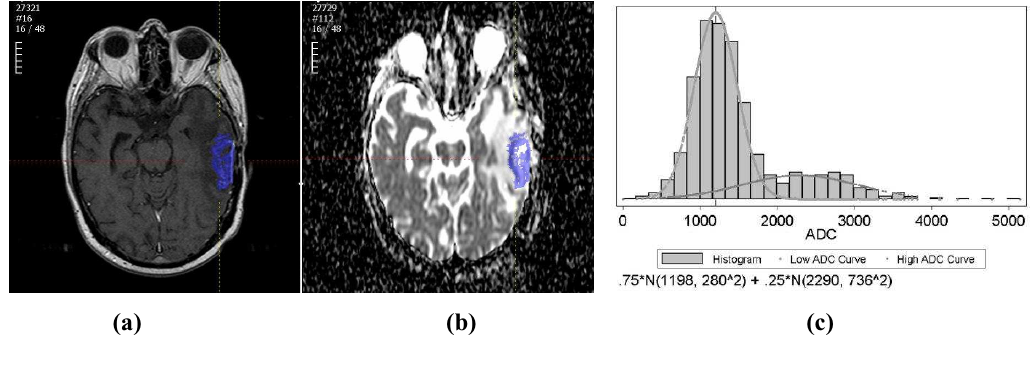
Figure 1. (a) An example of the tumor segmented on a T1wCE image; (b) An example of the tumor ROI mapped from T1wCE to ADC map; (c) An example of the tumor ADC histogram fitted by two-component Gaussian